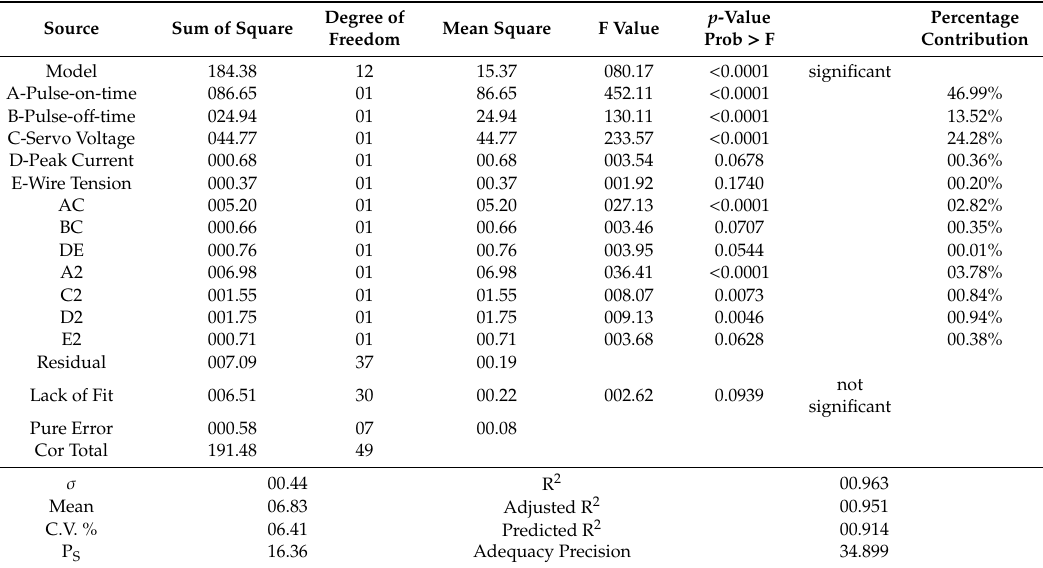
Table 7. Results of ANOVA analysis for the material removal rate